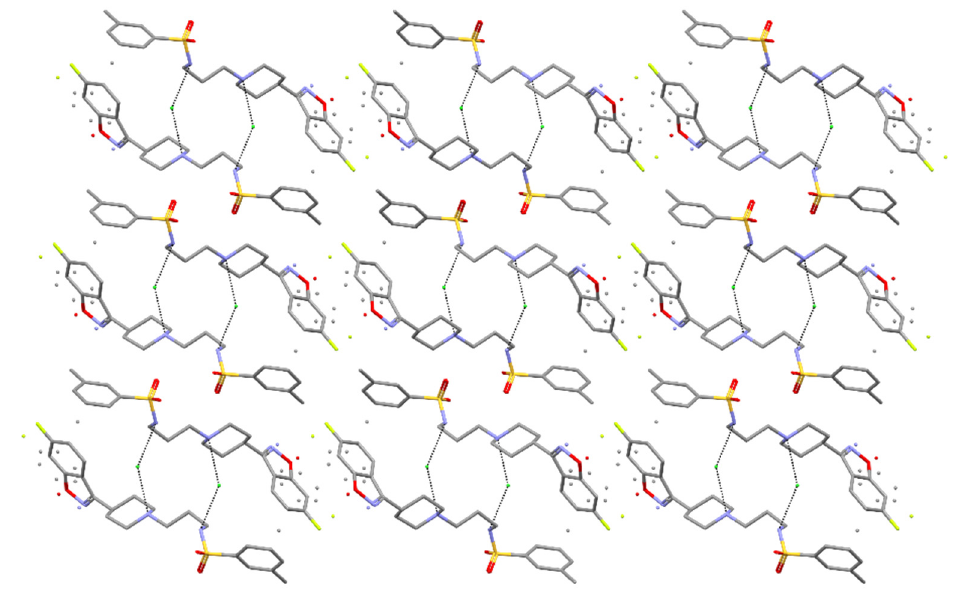
Figure 5. The crystal packing of MBS HCl , viewed along the b axis. Coordinates taken from [44].